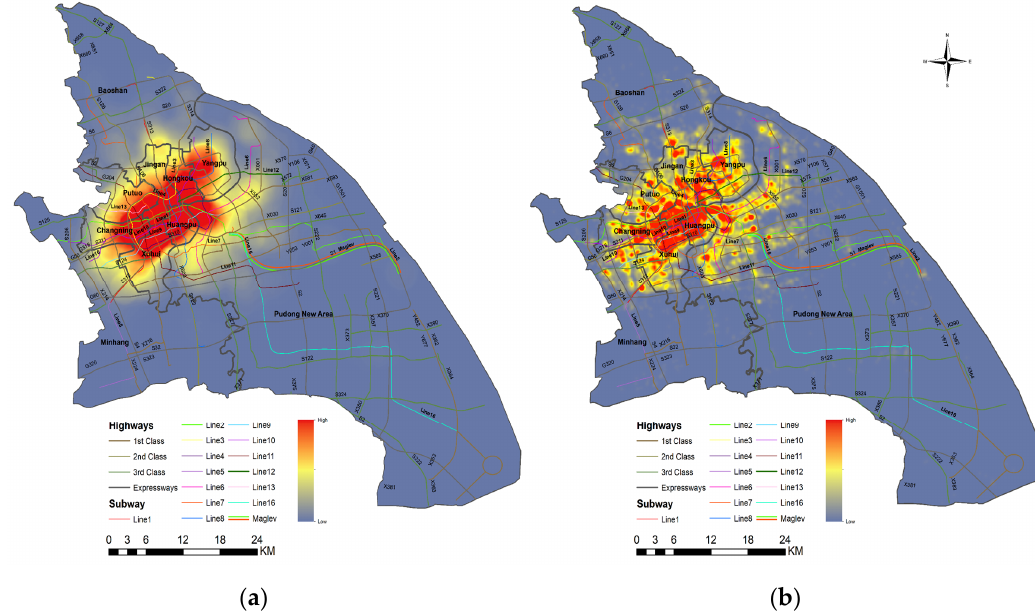
Figure 6. ( a ) Point density and ( b ) kernel density estimation (KDE) of check-ins distribution in the study area.